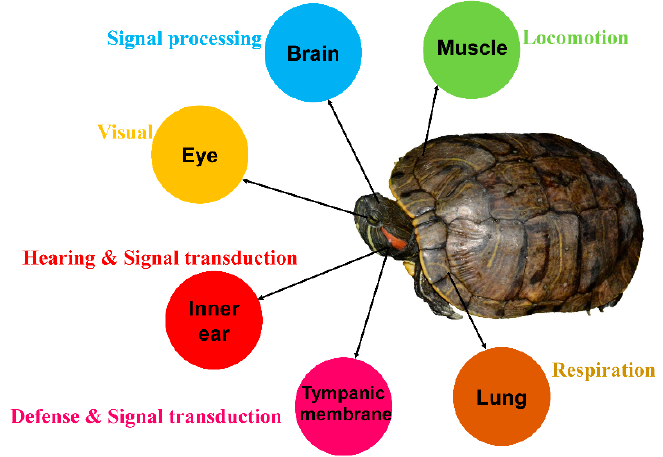
Animals 2022 , 12 , x FOR PEER REVIEW Figure 1. Biological functions of organs in Trachemys scripta elegans . Figure 1. Biological functions of organs in Trachemys scripta elegans .